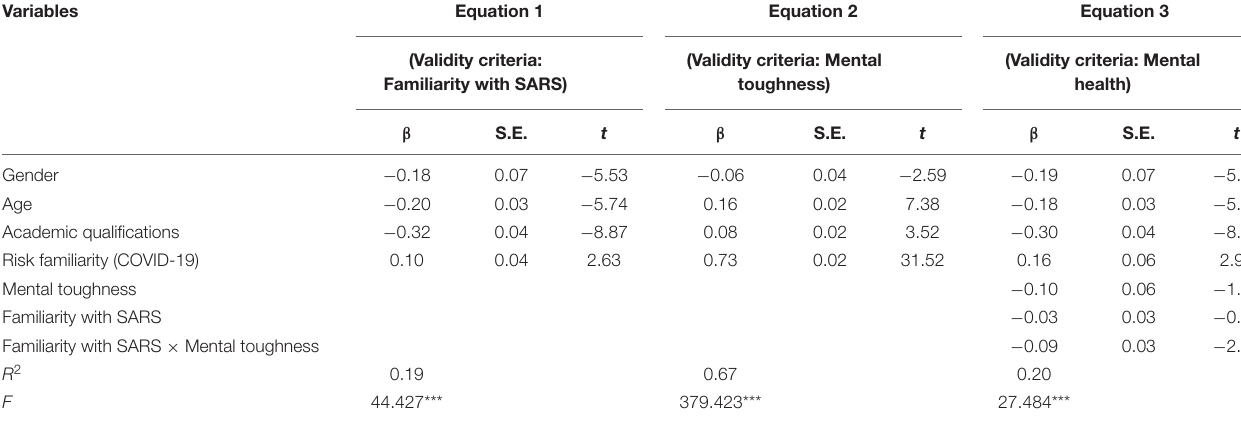
TABLE 4 | Test of the mediating effect of risk familiarity (COVID-19) on mental health.